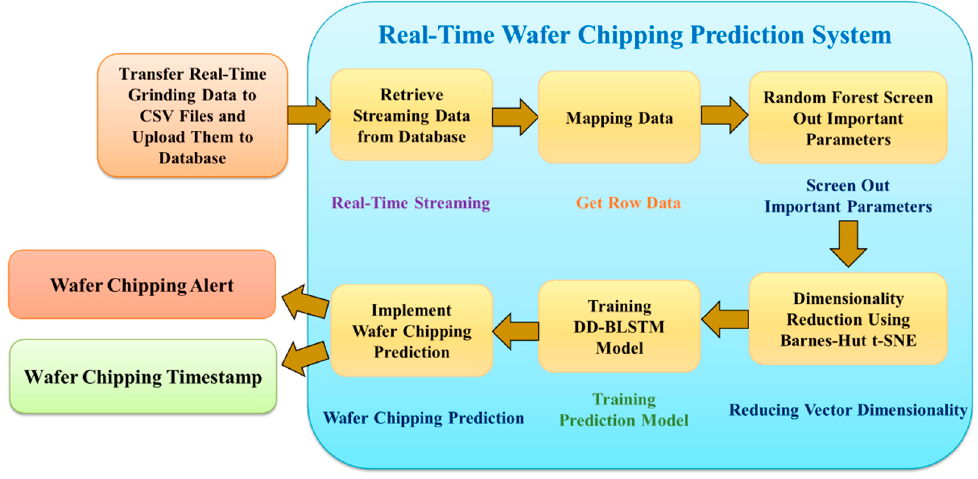
Figure 7. Execution flow.